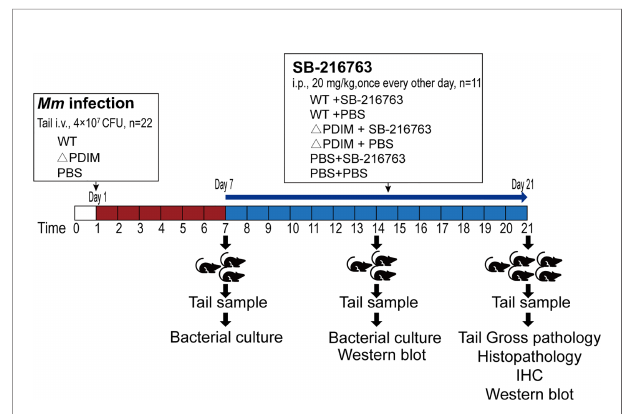
FIGURE 1 | Design and protocol for the animal experiment. Sixty-six C57BL/ 6 mice were divided randomly into three groups. Twenty-two animals were administered PBS by i.v. to the tail vein. Twenty-two were injected with WT Mm while another twenty-two received △ PDIM. After 7 days, the animals were divided randomly into two groups of eleven animals each. These groups were administered SB-216763 or PBS by i.p. every other day until sacri fi ce at 21 days. On days 7 and 14, three mice for each group were sacri fi ced, and then tails from them were sampled for detection of bacterial load and Western blot assays. On day 21, all the mice were sacri fi ced for assays. IHC, Immunohistochemistry